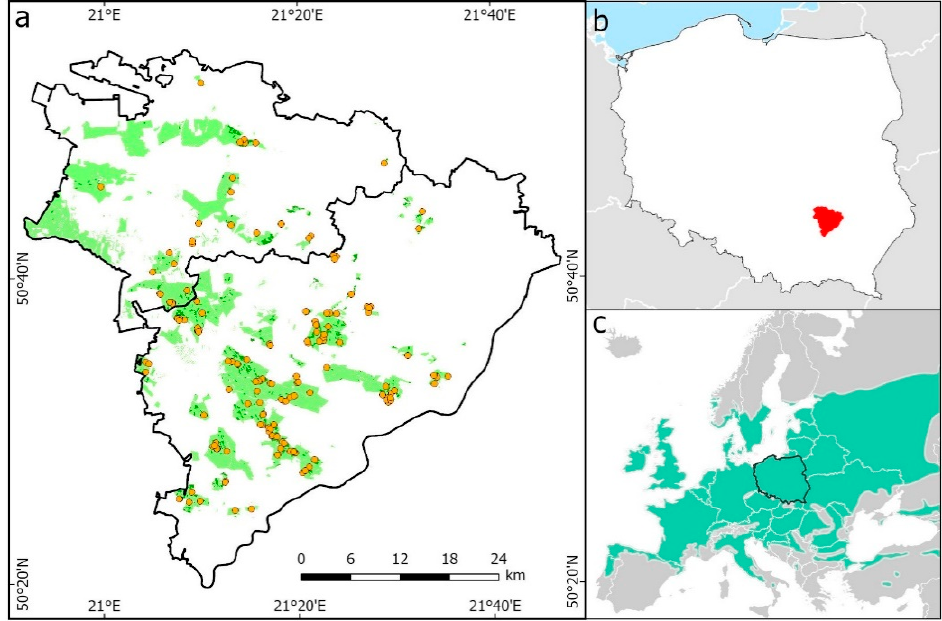
Figure 1. Location of sample plots (yellow points) in oak stands (dark green) ( a ); location of research area in Poland ( b ); the range of oak distribution in Europe ( c ).